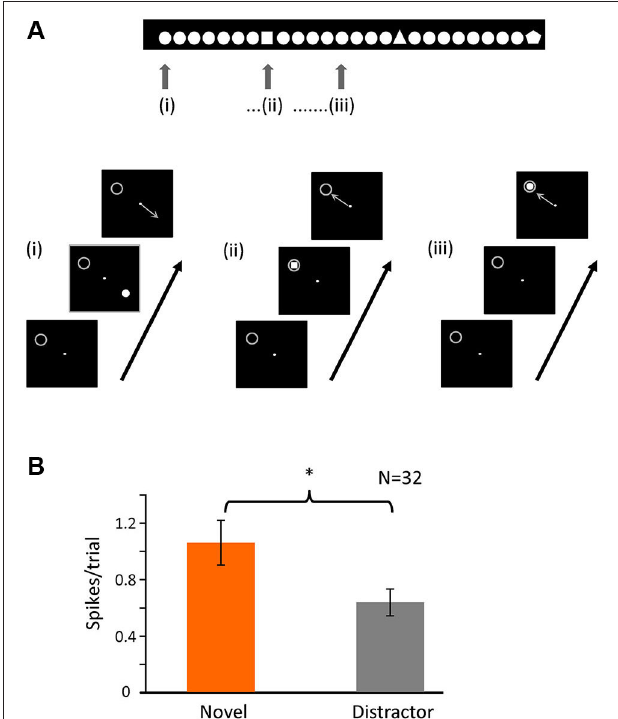
FIGURE 5 | Novelty of the stimulus is important for bursting . (A) Schematic representation of the second task. The animal had to fixate a dot in the center of the screen and maintain fixation in a 0.6 × 0.6 ◦ window. A single figure appeared in one of four different positions of the screen (at the same relative locations as task 1); the image disappeared after 500 ms, and the animal had to indicate the position of the stimulus with a saccade following fixation offset. In each recording session there was one figure that was repeated (distractor) and a small set of others (novel) that appeared randomly within the train as represented by the image above. The gray circle indicates the location of the receptive field and was not displayed. (B) Averaged number of spikes in bursts for the initial 20 to 80 ms after stimulus onset when the stimulus (novel or distractor) was over the RF ( p <